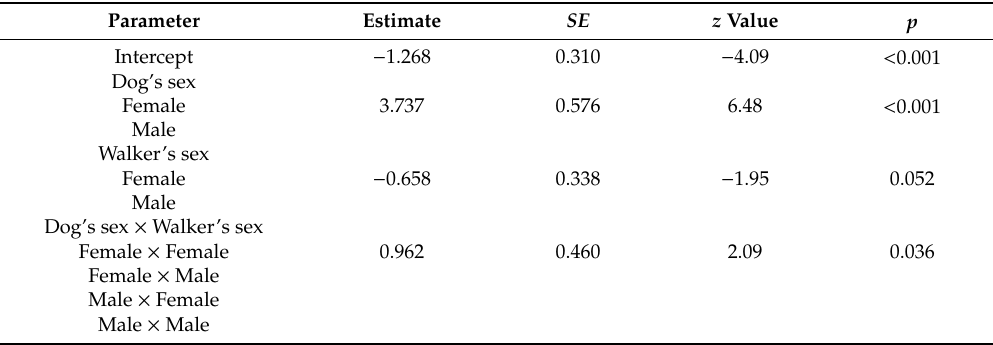
Table 5. E ff ects of sex of dog and sex of walker on the likelihood of dogs having a predominant urinary posture in which all limbs remain on the ground (i.e., lean-forward posture in males and squat posture in